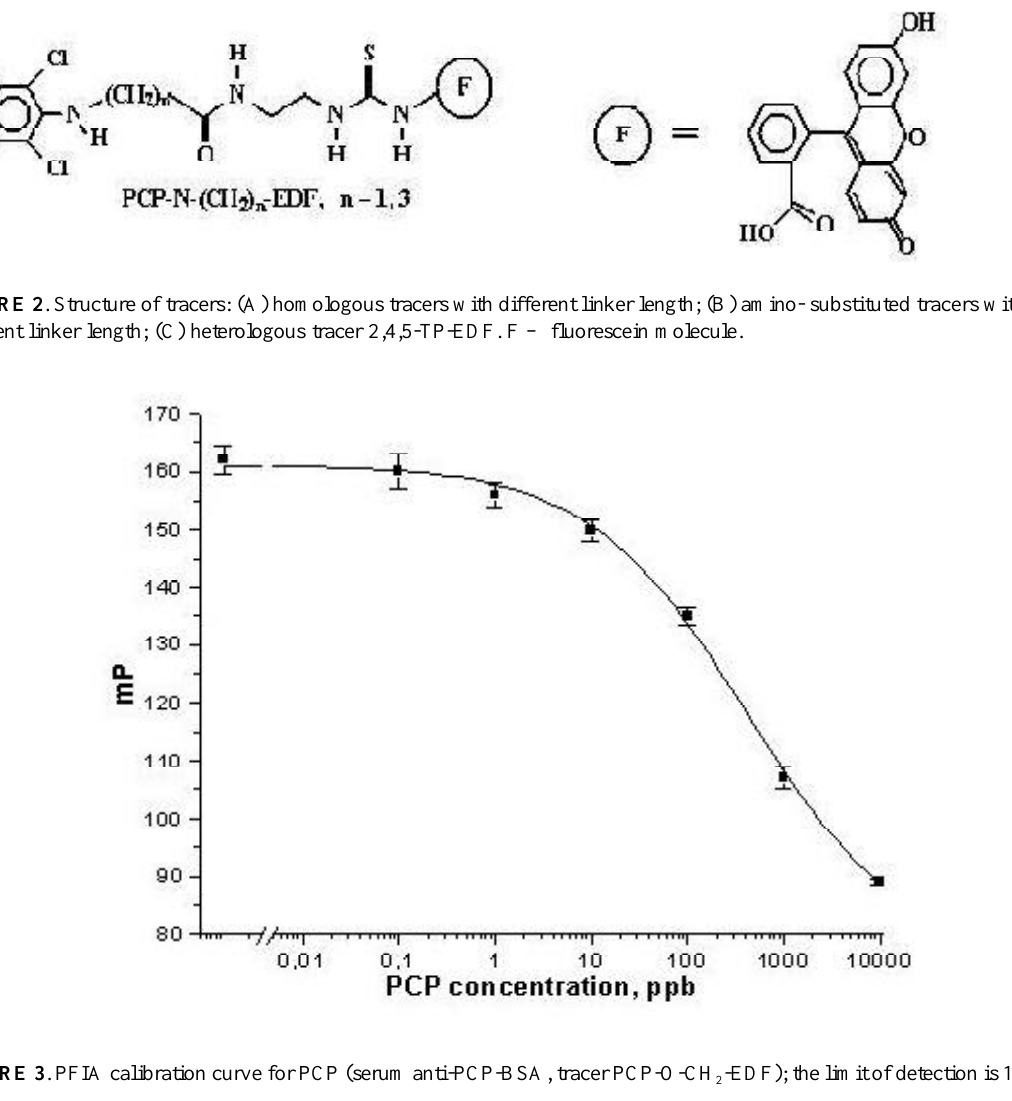
-EDF); the limit of detection is 10 2